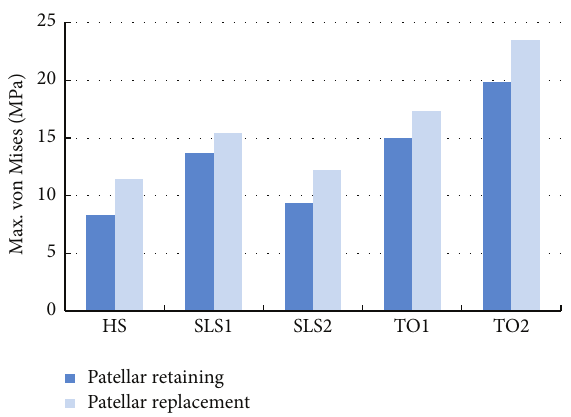
Figure 11: Peak equivalent stress curve of patella and patellar implant during gait